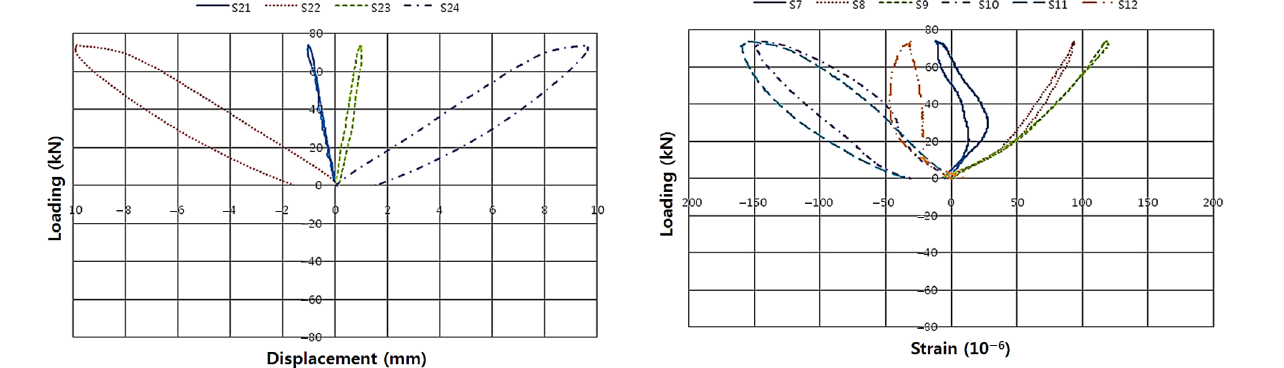
Fig. 10. Displacement curves for eccentric loading